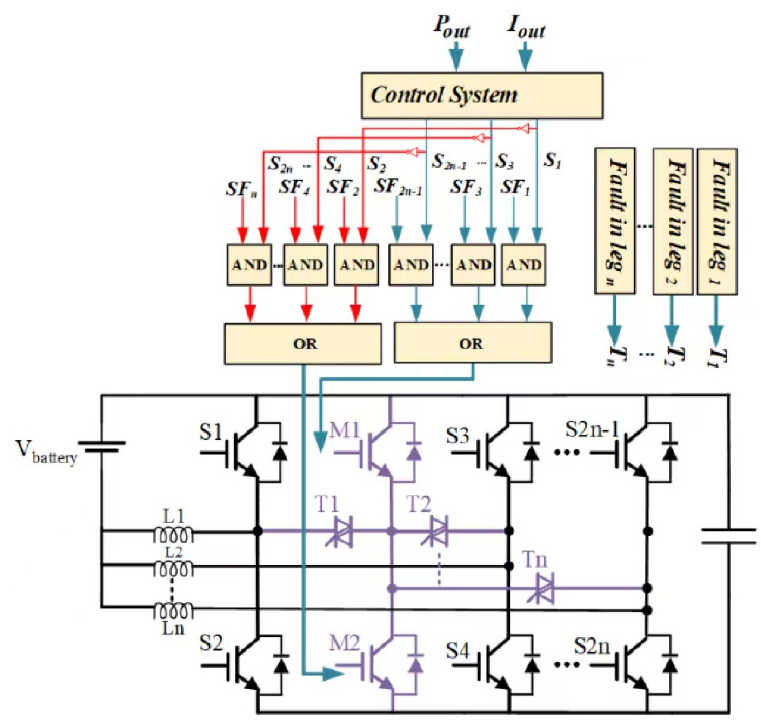
Figure 9. Fault–tolerant strategy control.